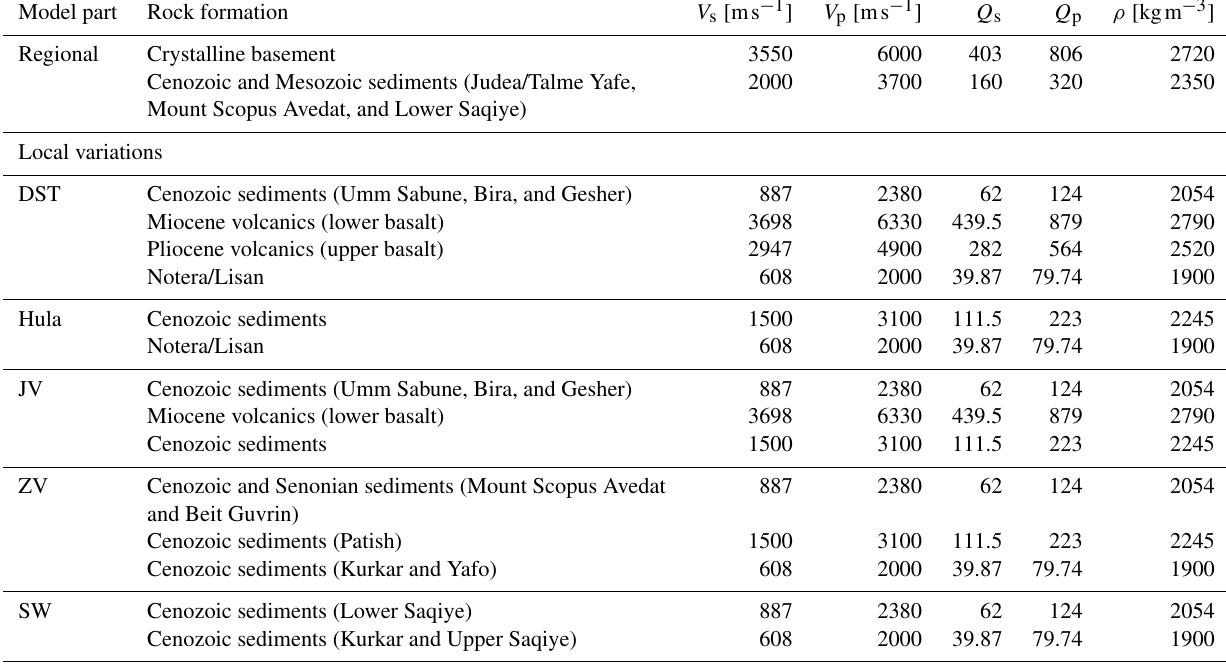
Figure 4. (a) The numerical model of the computational domain accompanied with subsurface cross-sections, marked with red dashed lines: (b) east–west cross-section through Zevulun Valley, C–C’, (c) east–west cross-section through the sedimentary wedge, B–B’, and (d) north–south cross-section through the DST trough, A–A’. Table 1. Material properties of the main stratigraphic units used in this work. Model